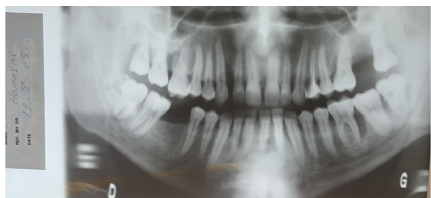
Figure 1: Preoperative panoramic X-ray showing generalized bone loss and missing teeth 27 and 46.